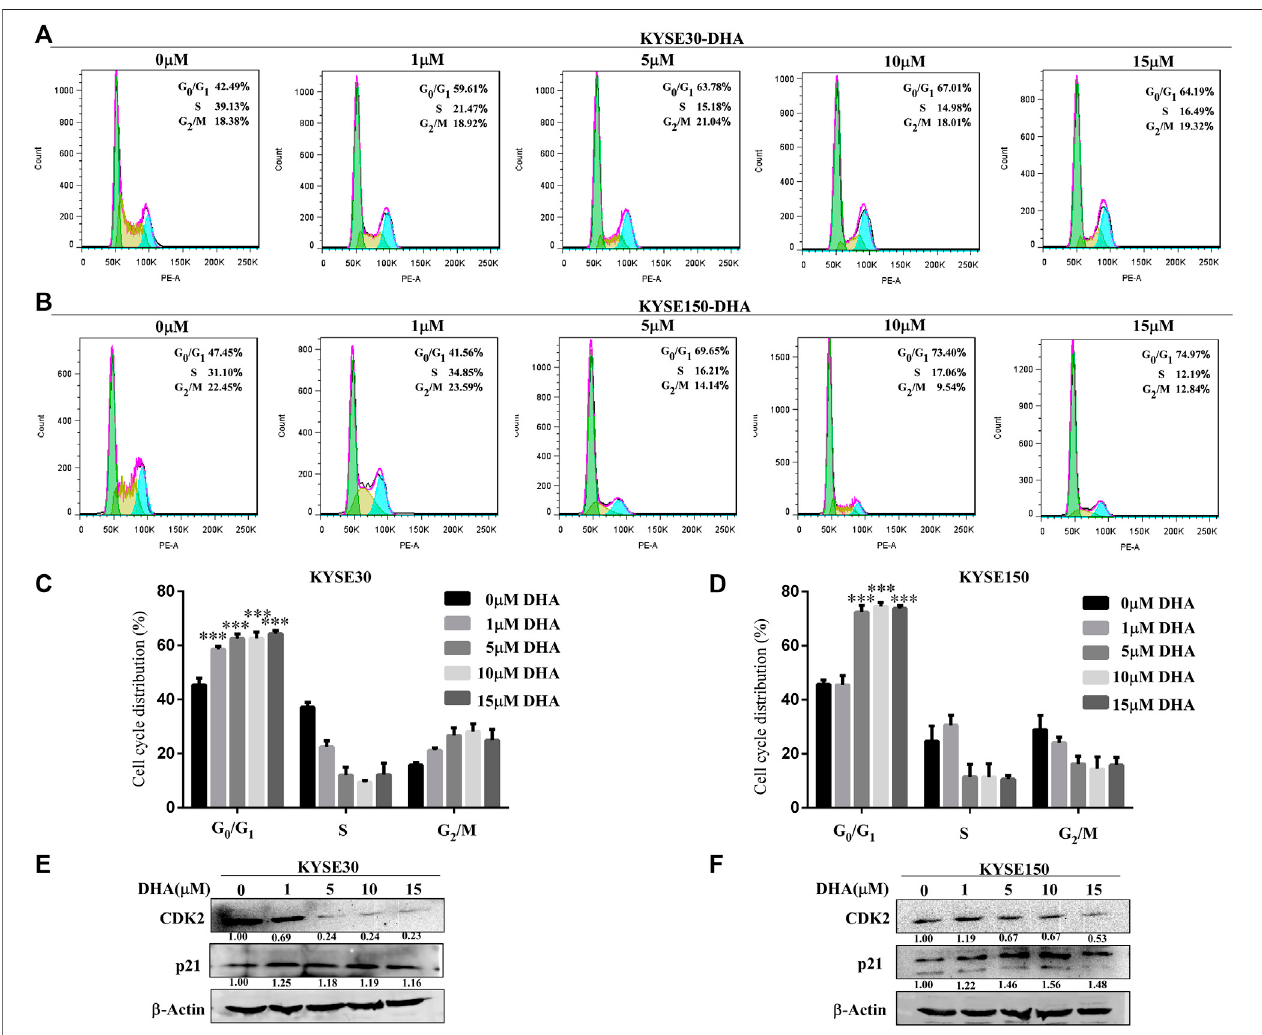
FIGURE 2| EffectsofDHAonthecellcycleprogressioninKYSE30andKYSE150cells. (A,B) KYSE30andKYSE150cellswerestainedwithpropidiumiodide(PI)andthe cellcycledistributionwasanalyzedusing fl owcytometryafterDHAtreatmentfor24 h. (C) ThequantitativecellcycledistributiondatainKYSE30cellsareshown (D) Thequantitative cell cycle distribution data in KYSE150 cells are shown. Data are presented as mean ± SD (*, p < 0.05; **, p < 0.01; ***, p < 0.001; n (cid:2) 3 per group, one-way ANOVA). (E) DHA affectedtheproteinlevelsofthecellcycle-relatedCDK2andp21inKYSE30cells (F) DHAaffectedtheproteinlevelsofthecellcycle-relatedCDK2andp21inKYSE150cells.